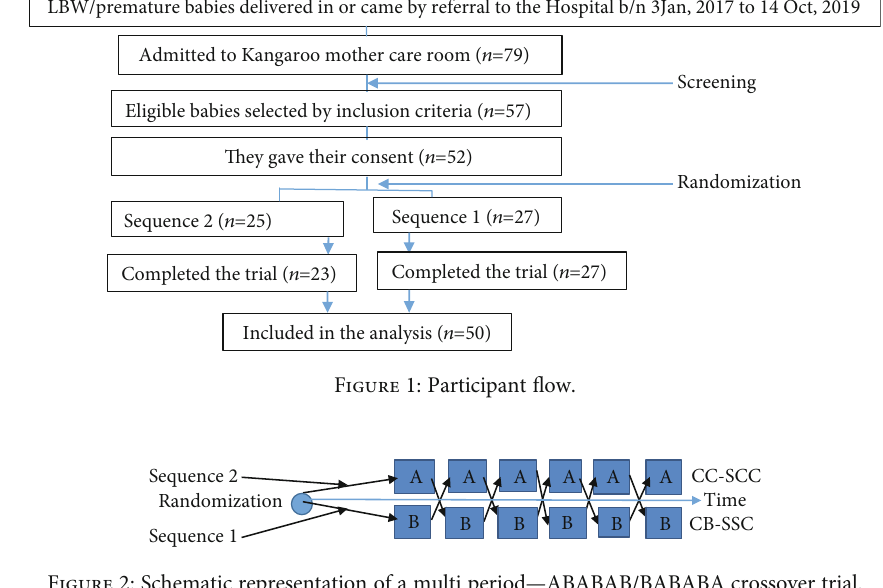
Figure 2: Schematic representation of a multi period — ABABAB/BABABA crossover